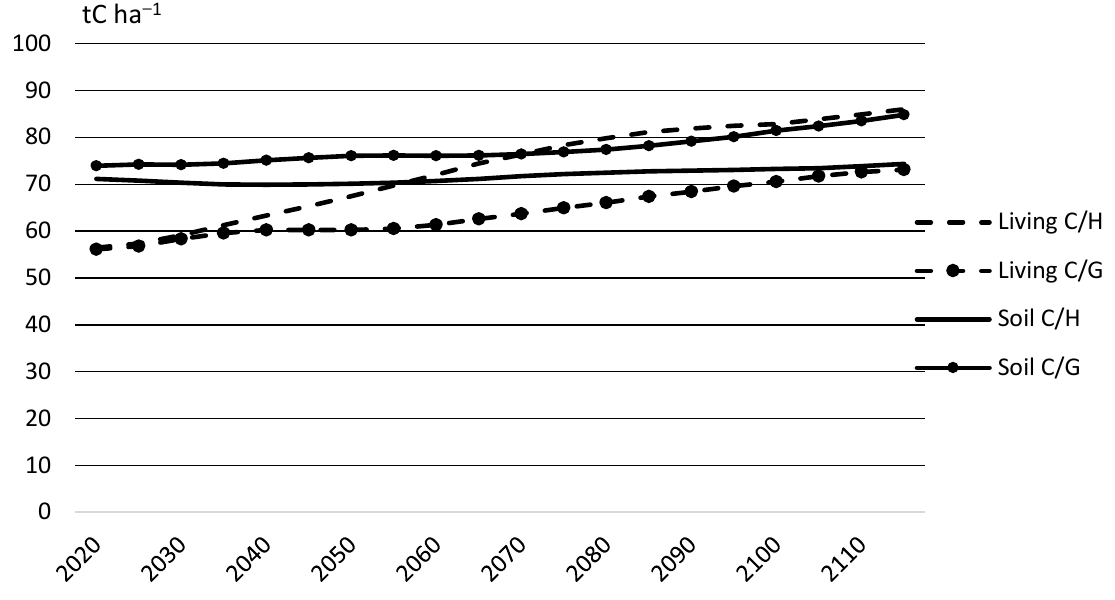
Figure 8. Pools of carbon in living matter and soil with GAYA (/G) and Heureka (/H).